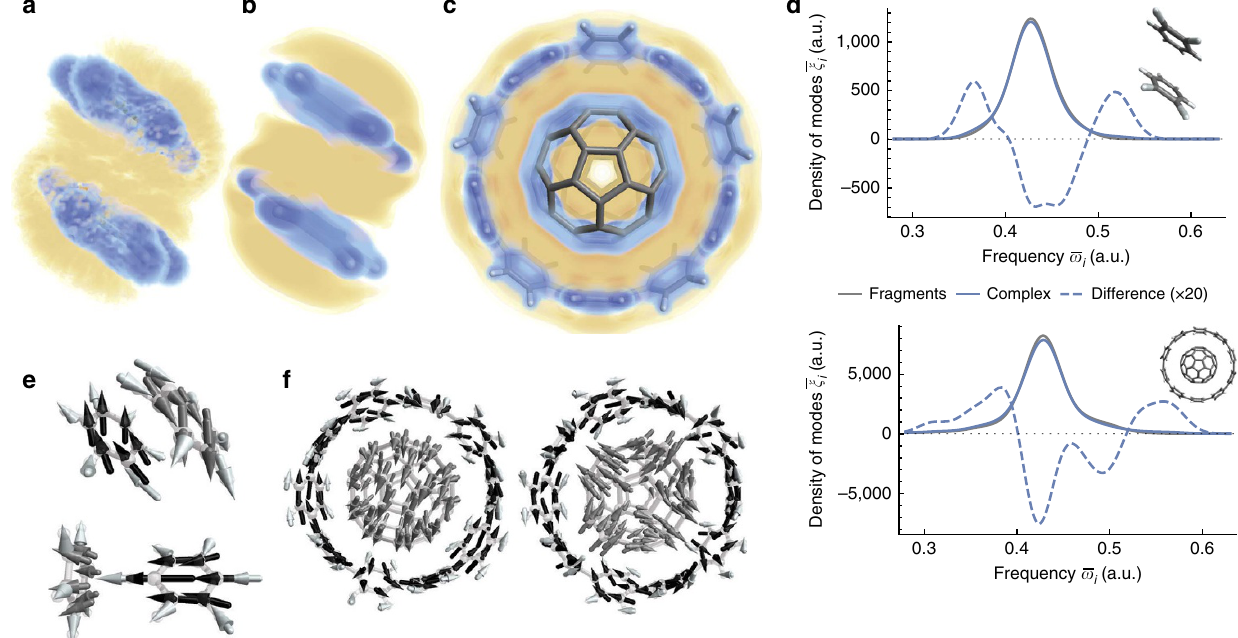
Figure 4 | Analysis of correlated charge fluctuations in supramolecular complexes and benzene dimer. ( a – c ) Electron density differences (charge polarization) between a complex and its isolated fragments induced by vdW interactions. Yellow and blue colour denote accumulation and depletion of charge density, respectively. Magnitude of the density difference is mapped to saturation of the colour with 50% saturation corresponding to the density of 2 (cid:3) 10 (cid:2) 5 and 4 (cid:3) 10 (cid:2) 5 a.u. for the benzene dimer and the complex C1, respectively. Charge polarizations were obtained either from a DFTcalculation with a self-consistent TS functional in the parallel-displaced benzene dimer (see Fig. 1) ( a ) or directly from the correlated MBD wavefunctions (see main text